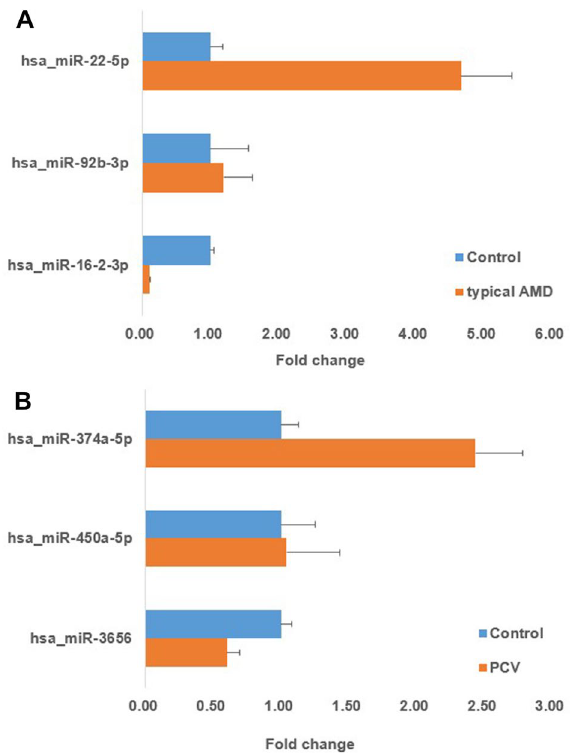
Figure 2. The relative expression levels of microRNAs (miRNAs) were assayed by quantitative PCR (qPCR) analysis and normalized to levels of A Caenorhabditis elegans miRNA-39 spike in control. The expression mode of three miRNAs of typical AMD ( A ) and three miRNAs of PCV ( B ) detected using qPCR. Error bars indicate standard deviations. AMD age-related macular degeneration, PCV polypoidal choroidal